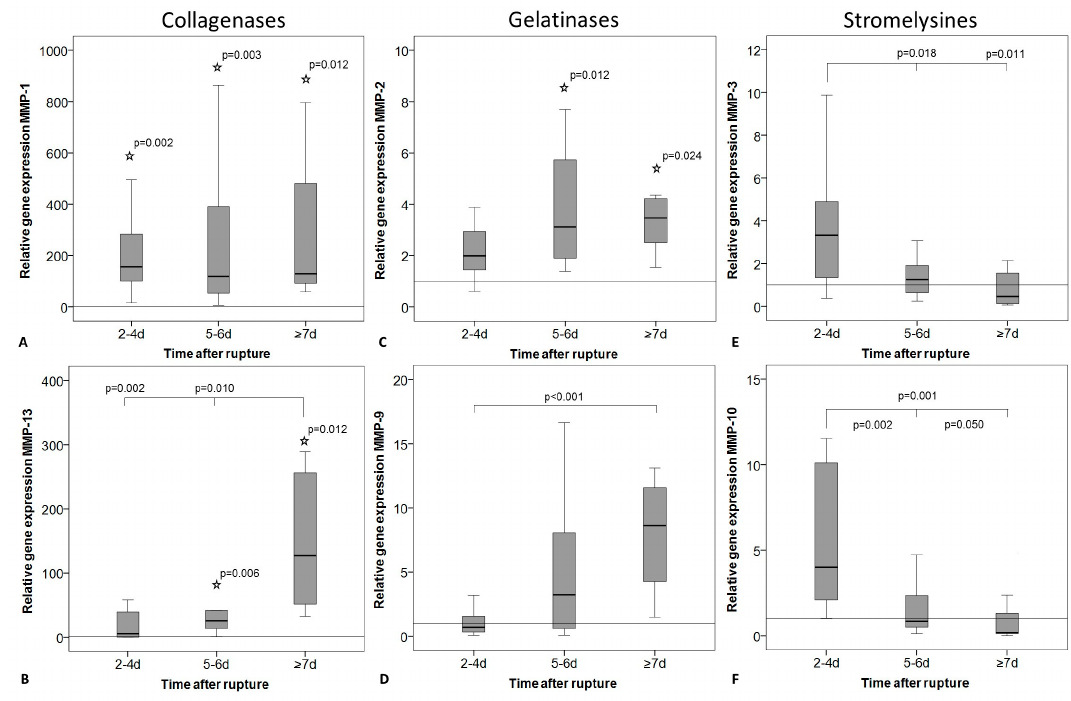
Figure 3. Relative gene expression of matrix metalloproteinases (MMPs) in intact tendon tissue (horizontal line, value = 1) and in tendon tissue of early (2–4 d), middle (5–6 d), and late ( ≥ 7 d) time after rupture. Measures of qRT-PCR were normalized to the expression of the house keeping gene 18S-rRNA using the Δ C t method with efficiency correction, given as fold change to the intact group (horizontal line, value = 1), and represented as box plot graphs. Significant differences to the intact group are marked with a star and time-related differences with a spanning line. ( A ) MMP-1, ( B ) MMP-13, and ( C ) MMP-2 expression was significantly lower in the intact tendons compared to the ruptured tendons from certain time-points marked with a star. ( A ) MMP-1 and ( C ) MMP-2 expression was not regulated over time, while ( D ) MMP-9 and ( B ) MMP-13 significantly increased with the time after rupture and ( E ) MMP-3 and ( F ) MMP-10 decreased.